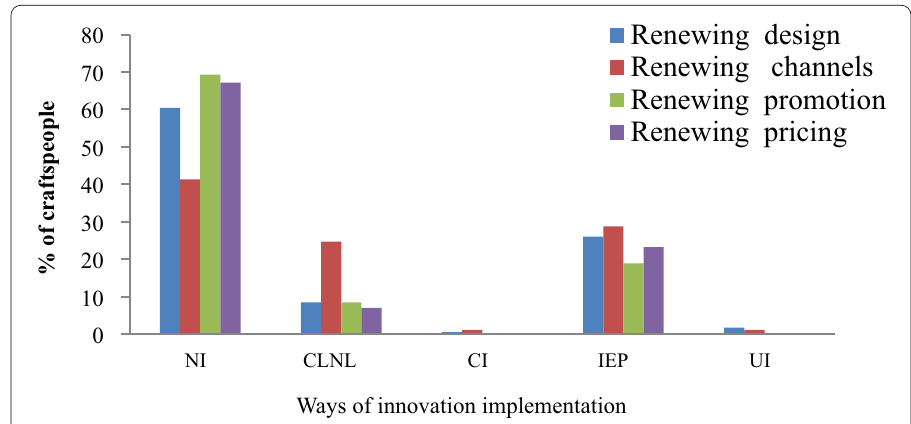
Fig. 6 Marketing innovation implementation. NI Not implemented, CLNL copied from local and national level, CI copied from international level, IEP improved from own experience and product, UI unique breakthrough